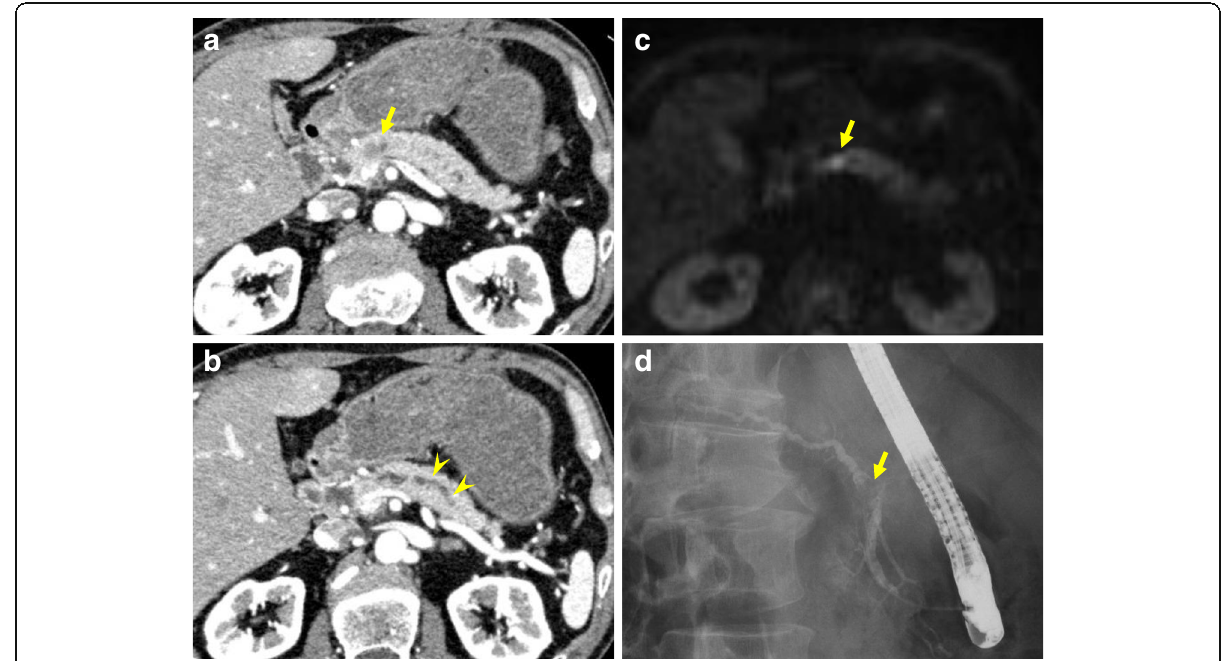
Fig. 1 Preoperative image findings in the first surgery. a , b CT showed a low-contrast tumor approximately 1 cm (arrow) in size and dilatation of the upstream main pancreatic duct (arrowhead). c MRI revealed a tumor showing a high signal by DWI at the stenosis of the pancreatic duct.